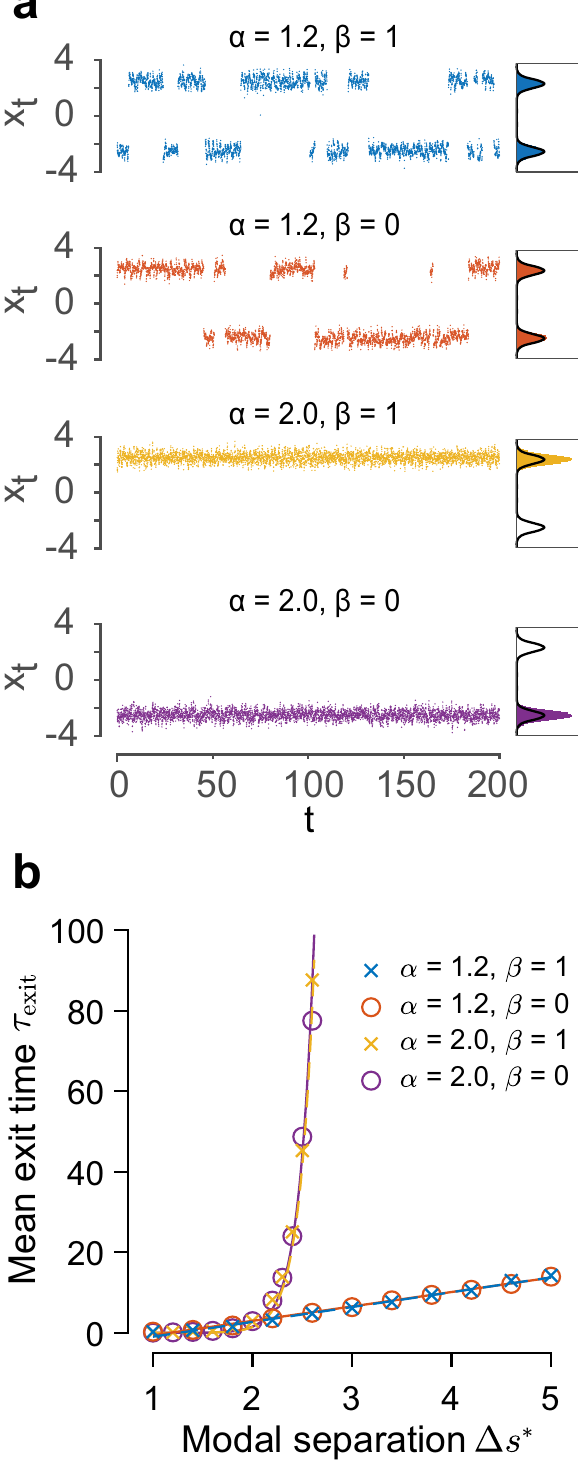
Fig.6|IllustrationofthecomputationpropertiesofFNSforsamplingbimodal distributions. a Sampling processes driven by fractional Lévy motion ( α =1.2, top two panels) are able to alternate between two modes rapidly (modal separation Δ s *=5), rather than being stuck at one mode as their non-fractional counterparts ( α =2.0, bottom two panels). Right panels: sample histograms and target dis- tribution (solid line). b Mean exit time of the sampling processes driven by frac- tional Lévy motion grows linearly with modal separation, whereas those driven by Brownianmotiongrow exponentially; averagedacross 24 trialsofduration T =10 4 . Circles and crosses represent results from the mathematical model; solid lines denote the fi tted exponential and linear